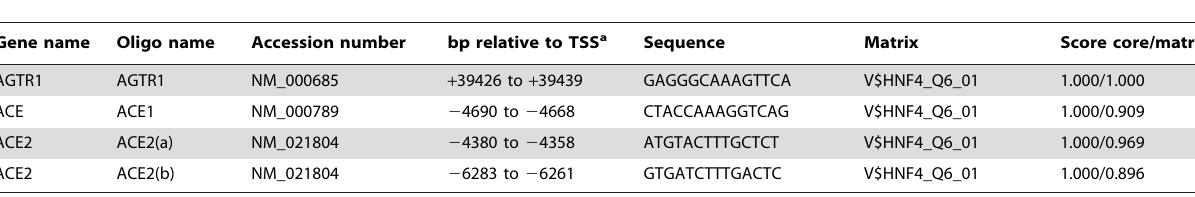
Table 4. Predicted binding sites for HNF4 a in different genes of the renin-angiotensin system.